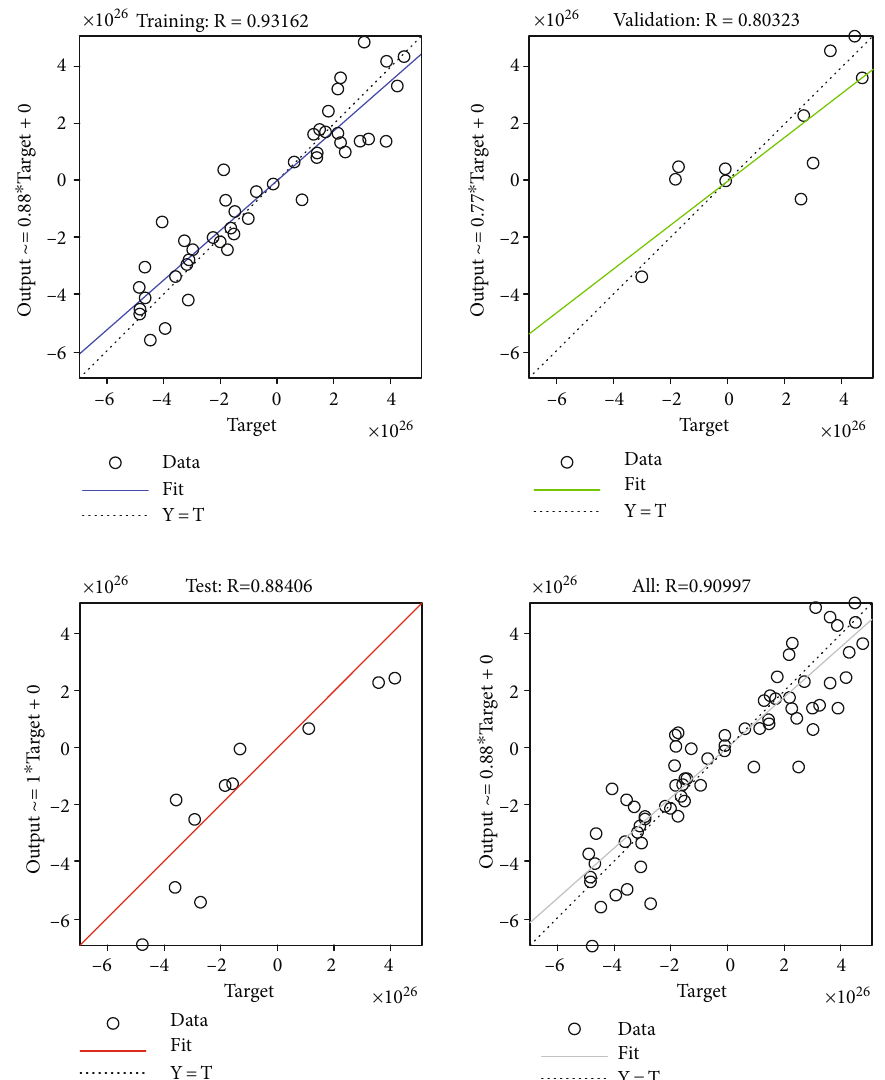
Figure 11: The regression plot for train, validation, and test